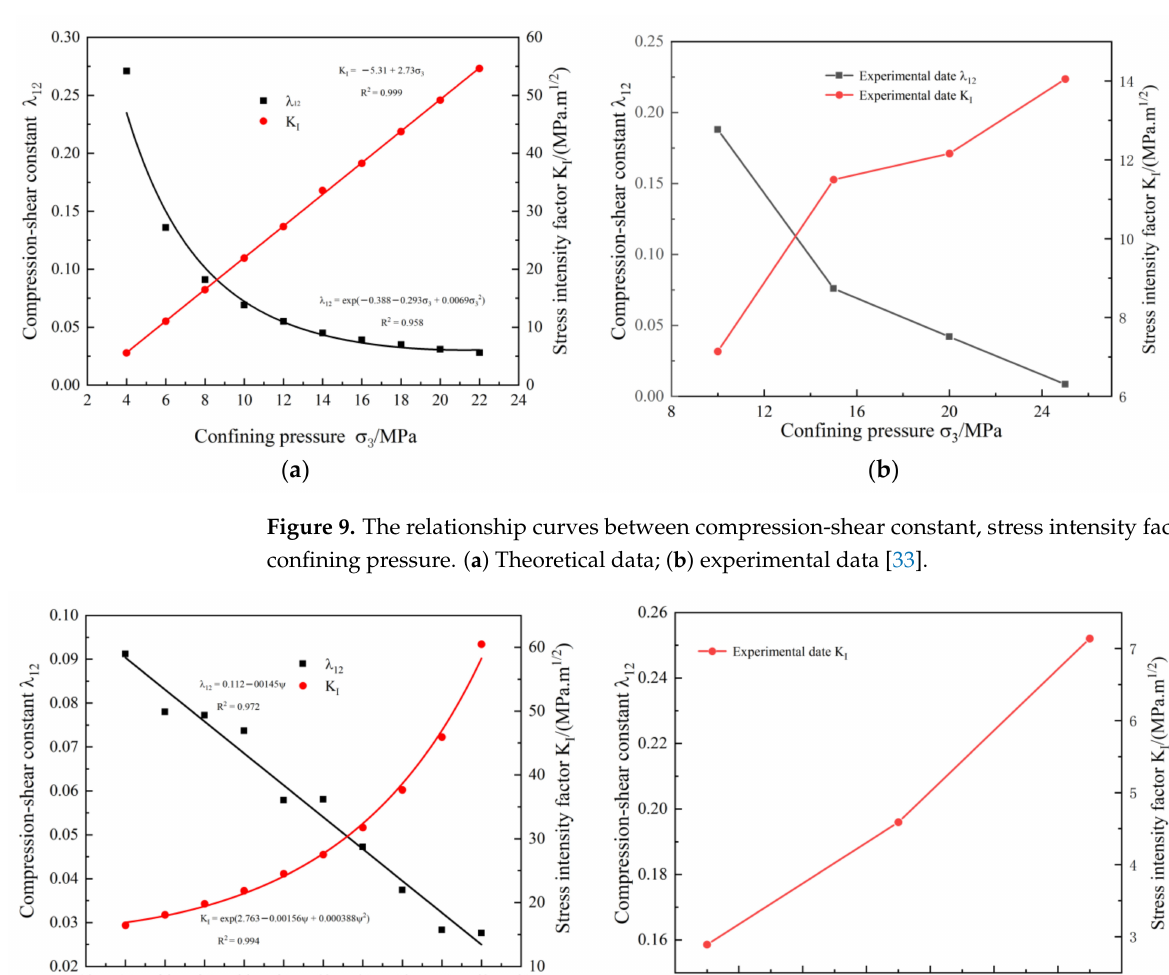
Figure 8. The relationship curves between compression-shear constant, stress intensity factor, and hydraulic pressure. ( a ) Theoretical data; ( b ) experimental data [33].